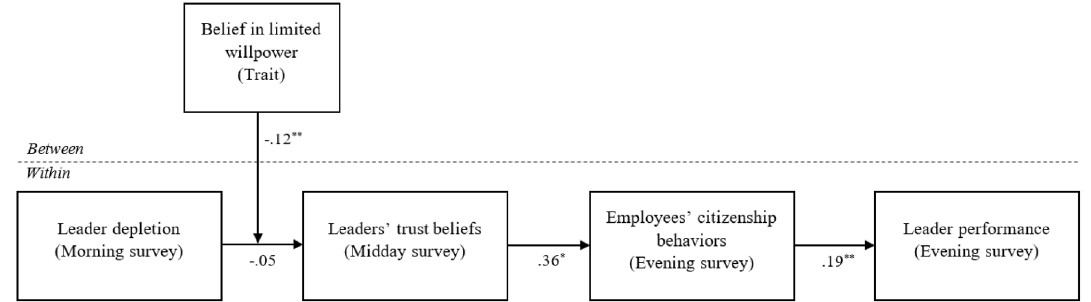
Figure 2. Results of multi-level path analysis (Study 3). Note. We controlled for current day working hours as well as leaders’ trust beliefs, leaders’ experienced citizenship behavior, and leader performance from the prior day. In addition, the distal effects of leader depletion on the endogenous variables were included. For clarity, these paths are not pictured in the model. * p < .05. ** p < .01. *** p <